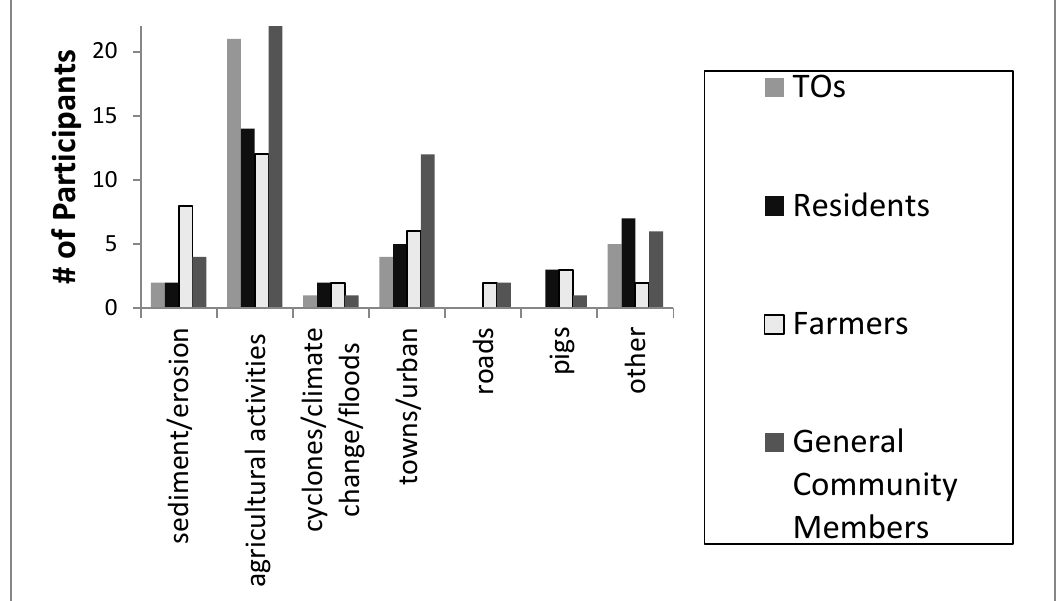
Figure A7. Perceptions of water quality issues/pollutant sources in the basin.